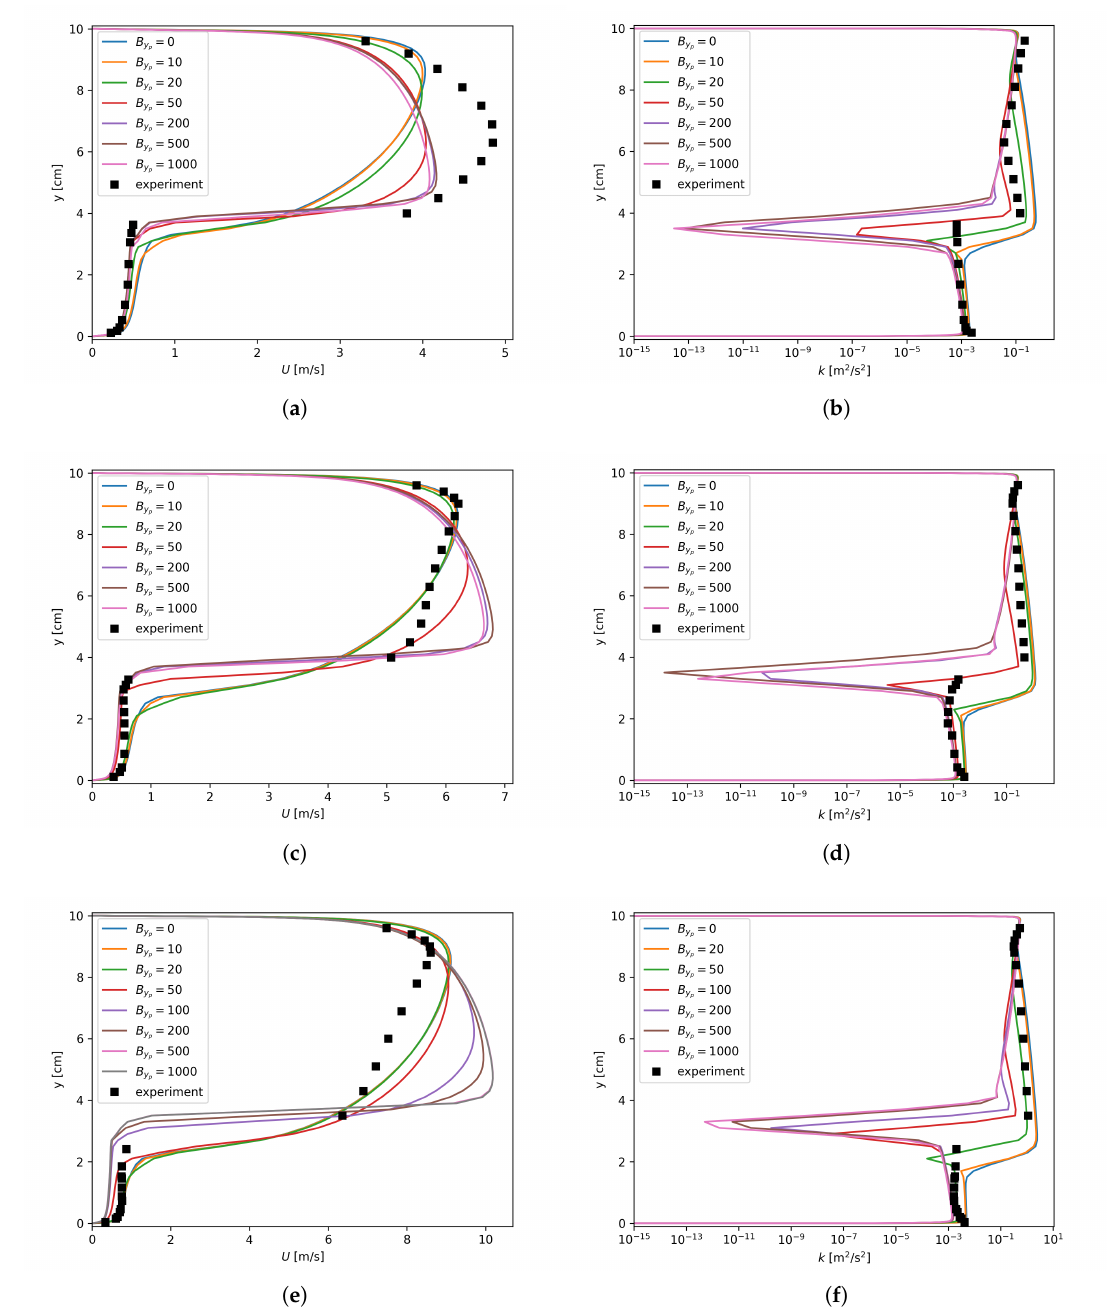
Figure A1. Axial velocity and turbulent kinetic energy dependency on B y axial velocity; ( b ) Run 250, k ; ( c ) Run 400, axial velocity; ( d ) Run 400, k ; ( e ) Run 600, axial velocity; ( f ) Run 600, k